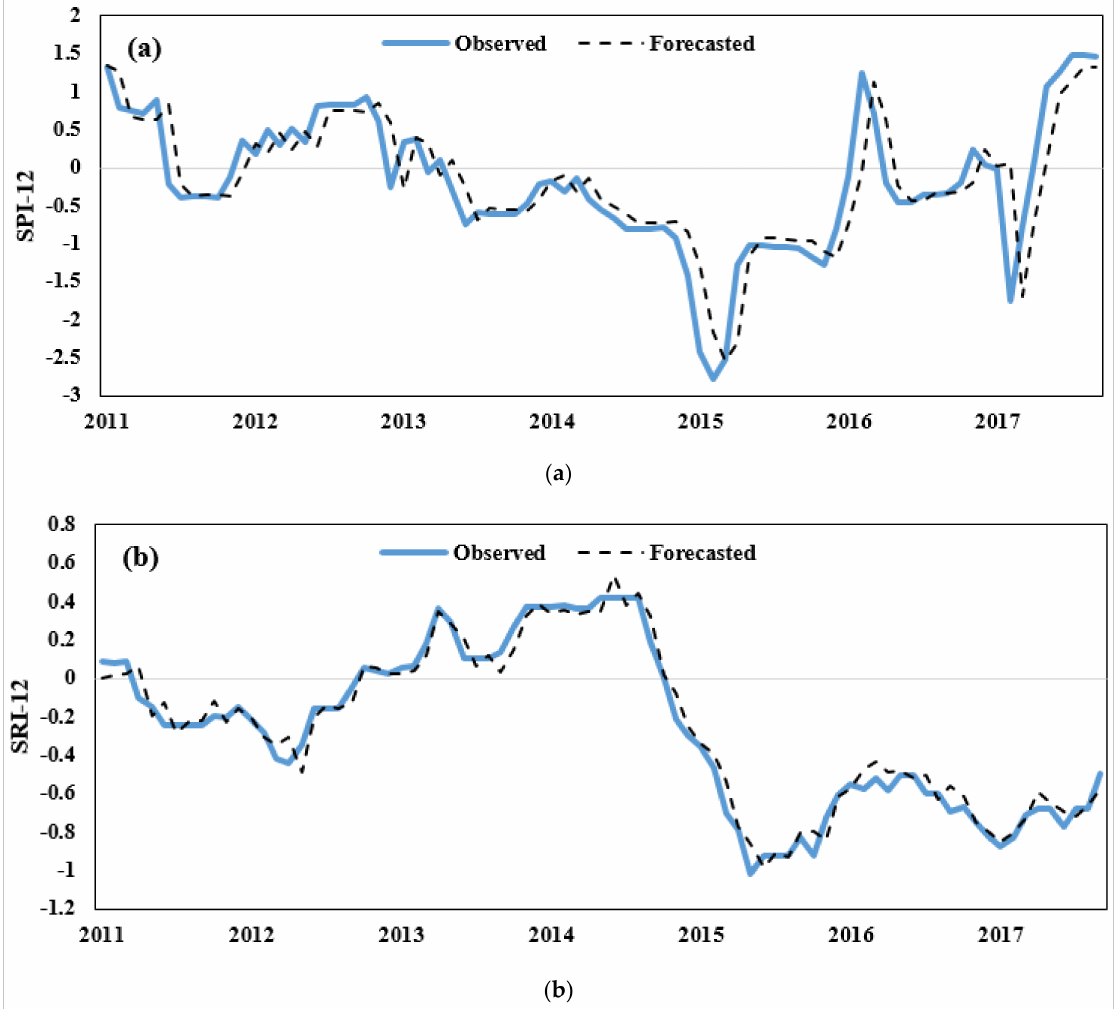
Figure 8. Comparison of SPI-12 ( a ) and SRI-12 ( b ) series observed and predicted in the validation phase for 1-month lead